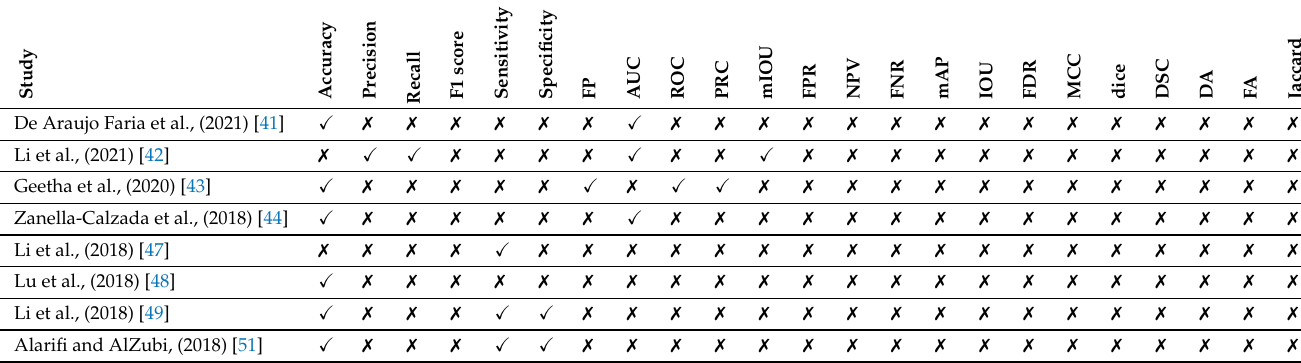
Table 12. Performance measures of deep learning